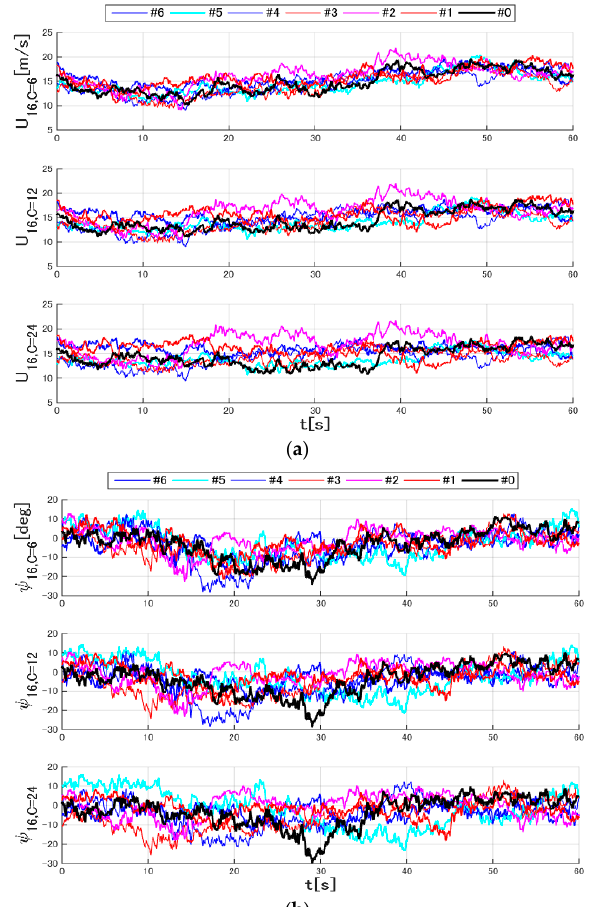
Figure 5. Example of the time history of the wind at the hub centre of each rotor (16 m/s at the centre hub, 0–60 s): ( a ) wind speed and ( b ) yaw angle.